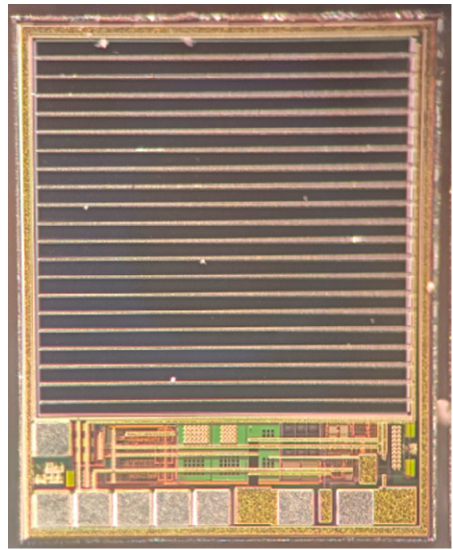
Figure 15. The micrograph of the chip.